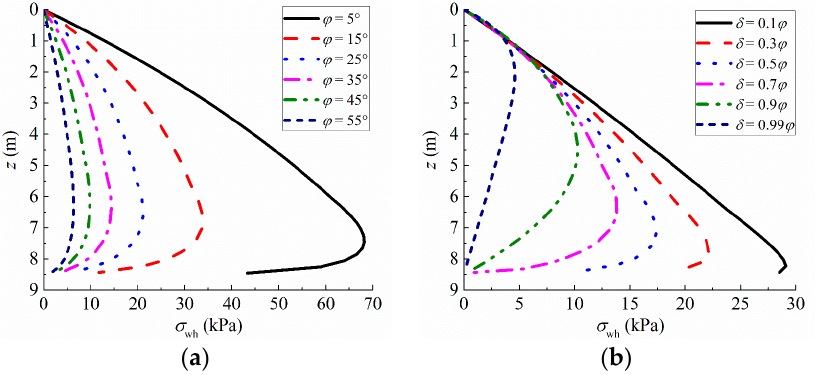
Figure 12. Influence of ( a ) φ and ( b ) δ on σ wh .